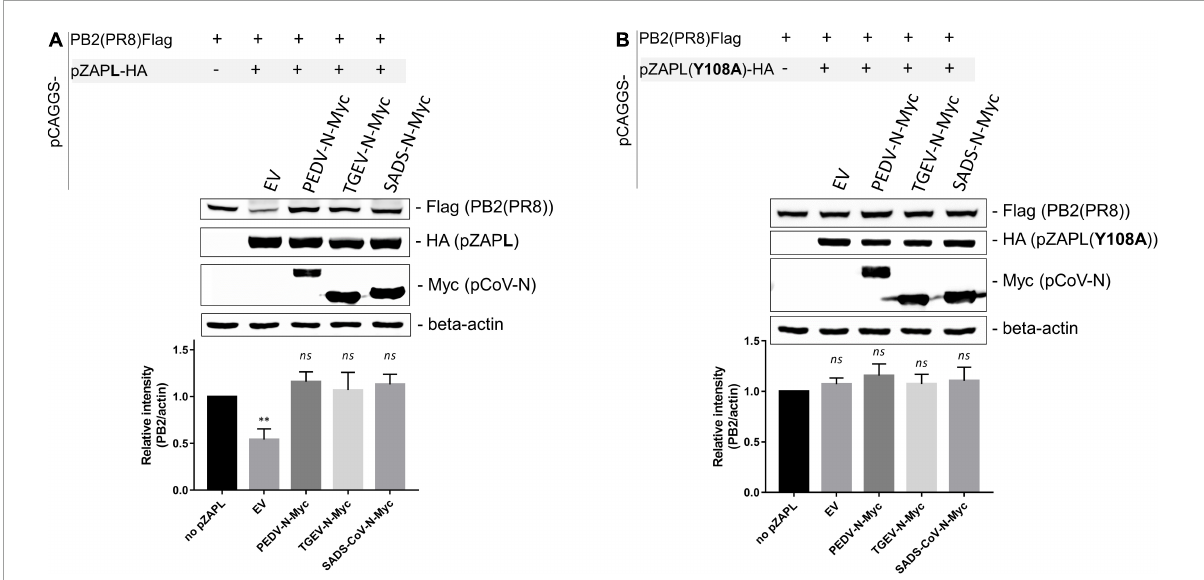
FIGURE7 pCoV-Ns reverses the repression of PB2 expression by zinc-finger antiviral protein (ZAP). (A,B) A pCAGGS plasmid expressing Flag-tagged PB2 was co-transfected into HEK293T cells with a plasmid expressing HA-tagged pZAPL (A) or the non-functional ZAP mutant, ZAP (Y108A) (B) , and a plasmid encoding the indicated pCoV-N protein. An empty vector plasmid served as a control. At 48 hpt, cells were lysed, and protein expression was analyzed by SDS-PAGE/western blotting. The western blotting results shown are representative of three independent experiments. The relative band intensities of PB2-FLAG and beta-actin under each lane were analyzed using Image Lab software (Bio-Rad Laboratories, CA, United States). Values shown are the means ± SD of three independent measurements (Student’s t -test, ** p < 0.005).